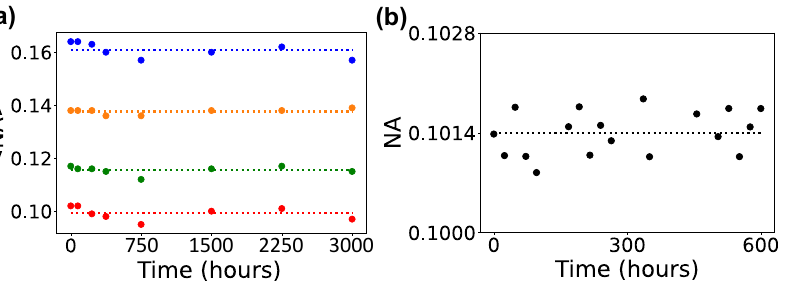
Figure 5: Temporal stability. (a) Average numerical aperture <NA> over time under laboratory ambient conditions for 3D-printed waveguides cured via blanket UV with identicalUVdosesas inFigure3,showingnosigni fi canteffectofaging.(b)Numerical apertureNAover timefora 3D-printedwaveguideunder operation conditions with 0.25 mW, 660 nm light continuously injected. No aging effect could be found after ∼ 600 hours of